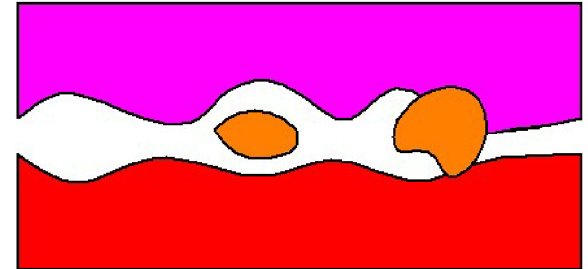
Fig. 4 Illustration of wear mechanism.